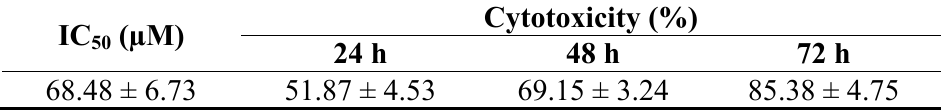
Data shown as mean ± SD, n =